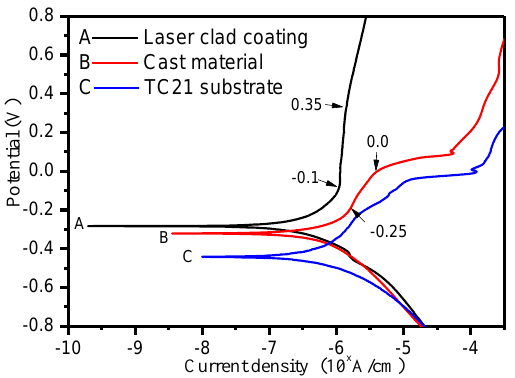
Figure 7. A comparison of the potentiodynamic polarization plots of the TC21 substrate and the Ti–20%Si alloys produced by laser cladding and metal mold casting.